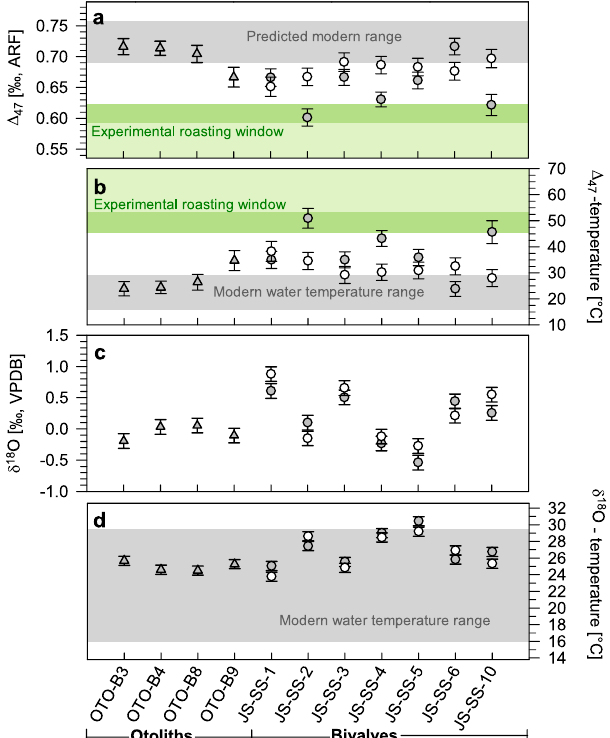
Figure 3. Clumped and oxygen isotopic composition with corresponding water temperature estimates of mid- Holocene fish otoliths and bivalve shells. ( a ) Clumped-isotopic composition ( Δ 47 ) reported in the absolute reference frame (ARF) defined by Dennis et al . 24 of bulk otoliths (grey triangles), bulk bivalve shells (grey circles) and hinge samples from the bivalve shells (open circles). Error bars represent mean standard errors of the individual measurements. The grey area represents the theoretical Δ 47 -range based on modern local water temperature data 31 translated into Δ 47 -values using the equation of Dennis et al . 24 . The shaded green area represent the experimentally determined Δ 47 -window for roasting at 174 ± 13 °C for 6 hours (light green) and realistic cooking duration of > 30 minutes (dark green). ( b ) Δ 47 -based water temperature reconstruction using the equation of Dennis et al . 24 with modern water temperature data 31 . Shaded green areas represent the experimentally determined Δ 47 -window of the roasting treatment translated into water temperature for 6 hours (light green) and realistic cooking duration of > 30 minutes (dark green). ( c ) Oxygen isotopic composition of bulk fish otoliths, bulk bivalve shells and hinge samples from the bivalve shells. ( d ) Oxygen-isotope-based water temperature reconstructions for the otoliths using the equation of Thorrold et al . 33 assuming a constant δ 18 O + 0.68‰ VSMOW 32 and oxygen-isotope based water temperature reconstructions for the Seawater value of bivalve shell samples using the equation of Grossman & Ku 30 assuming a constant modern δ 18 O Seawater value of + 1.57‰ VSMOW 31 with the modern local water temperature range 31